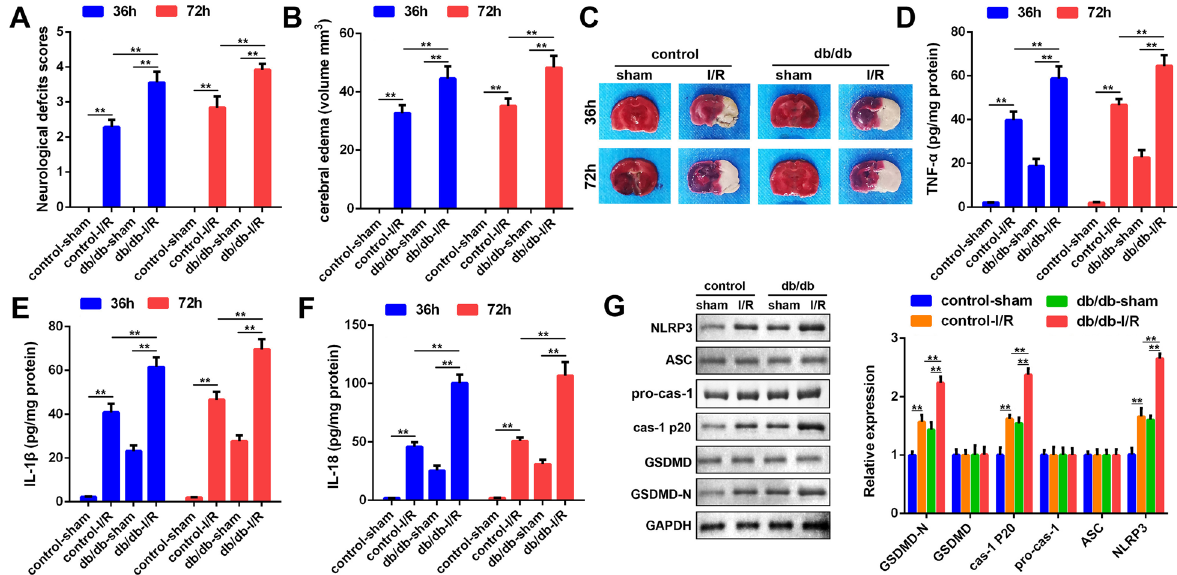
Fig. 1 Diabetic mice suffered from worse cerebral injury relative to the control mice after cerebral I/R. A Neurological scores were assessed in the control and diabetic mice underwent I/R or sham operation. The assessment was performed 36 h (blue bar) and 72 h (red bar) after operation. B Encephaledema volume of the brain slices were calculated according to the formula: V and A2: front and back encephaledema area of the slides (mm 2 ); t: thickness of the slides (mm). C The brain tissues were stained by TTC solution. Pale area represented for encephaledema. The concentrations of TNF-α ( D ), IL-1β ( E ), and IL-18 ( F ) in the brain tissues were measured by ELISA kit. G The protein expression (GSDMD-N, GSDMD, caspase-1 p20, pro-caspase-1, ASC and NLRP3) in the control-sham, control-I/R, db/db-sham and db/ db-I/R groups were detected by western blot. ** P < 0.01, I/R,